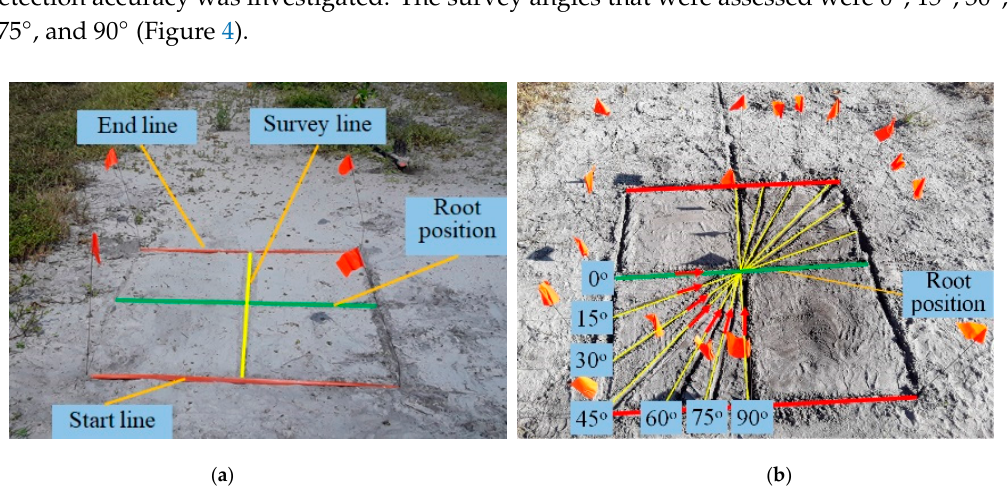
Figure 4. Single-factor root detection experiments: ( a ) Start line, end line and survey line; ( b ) Survey line direction experiment.